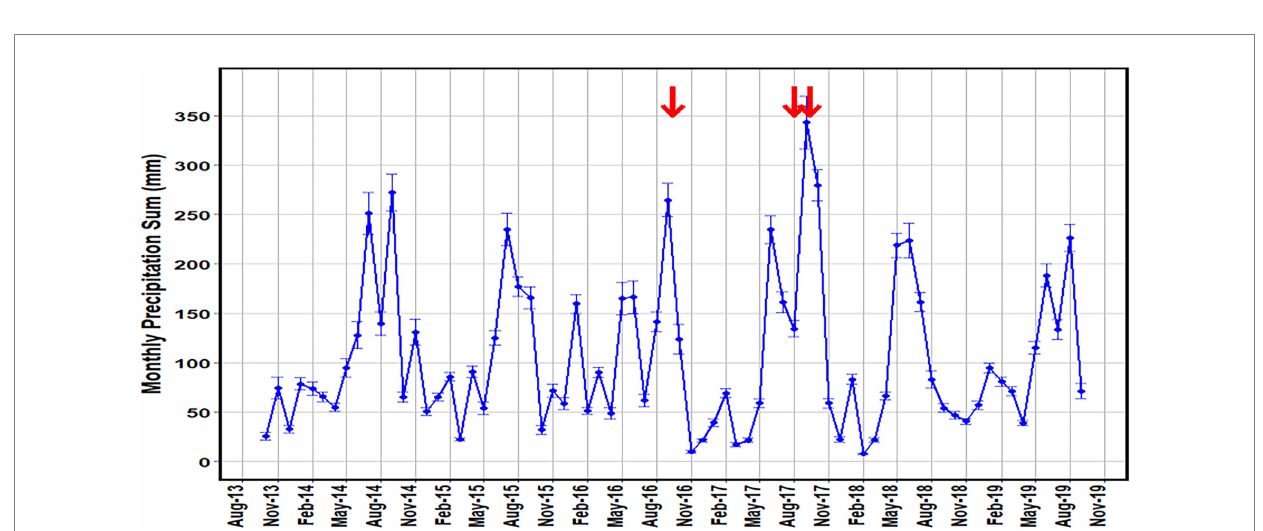
FIGURE 5 Mean monthly precipitation sum (mm) for land stations in Brevard County, Florida (NOAA). Error bars of one standard error are added to show the variance of the values. Red arrows indicate tropical systems that passed over or near the sampling sites during the sampling